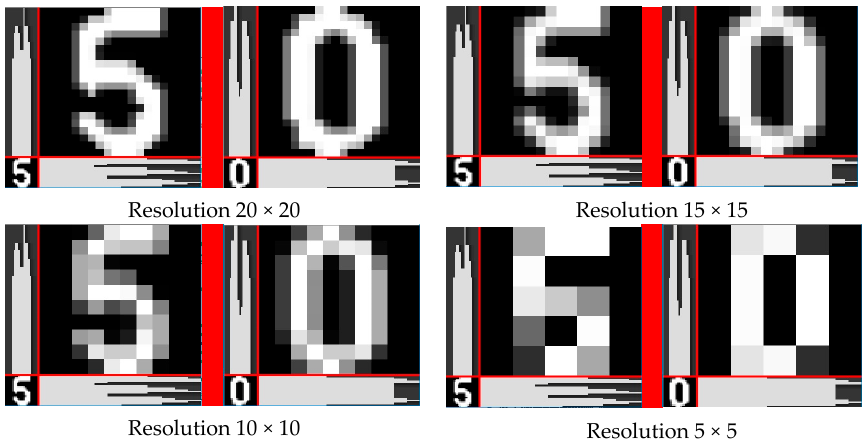
Figure16. Three feature quantities at each resolution for the extracted number 50.